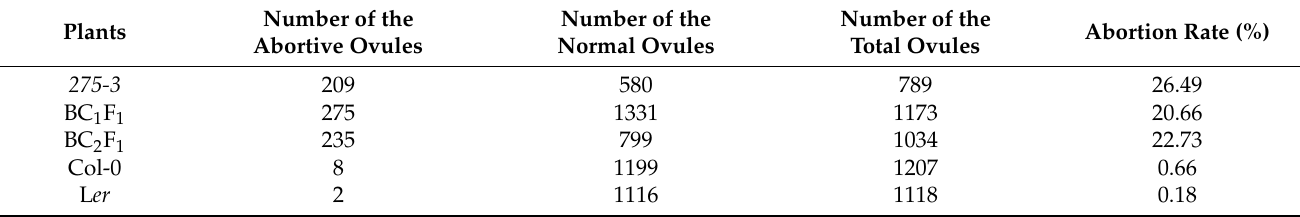
Table 1. The abortion ratios of Arabidopsis mutant 275-3 and its